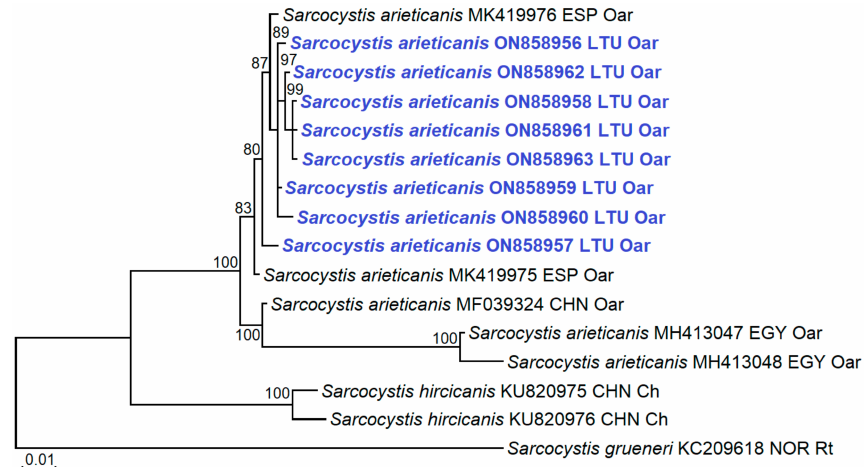
Figure 2. Phylogenetic trees of selected Sarcocystis spp. based on cox1 sequences showing genetic relatedness of isolated sarcocysts to S . arieticanis . The tree was rooted on S . grueneri . The figures next to the branches show the bootstrap support values. Sequences obtained in the present study are marked in blue. The final alignment consisted of 3 taxa, 16 sequences, and 894 aligned nucleotide positions. The Kimura 2-parameter + G model was chosen for the phylogenetic analysis. CHN: China, EGY: Egypt, ESP: Spain, LTU: Lithuania, NOR: Norway, Ch: Capra hircus, Oar: Ovis aries, Rt: Rangifer tarandus.